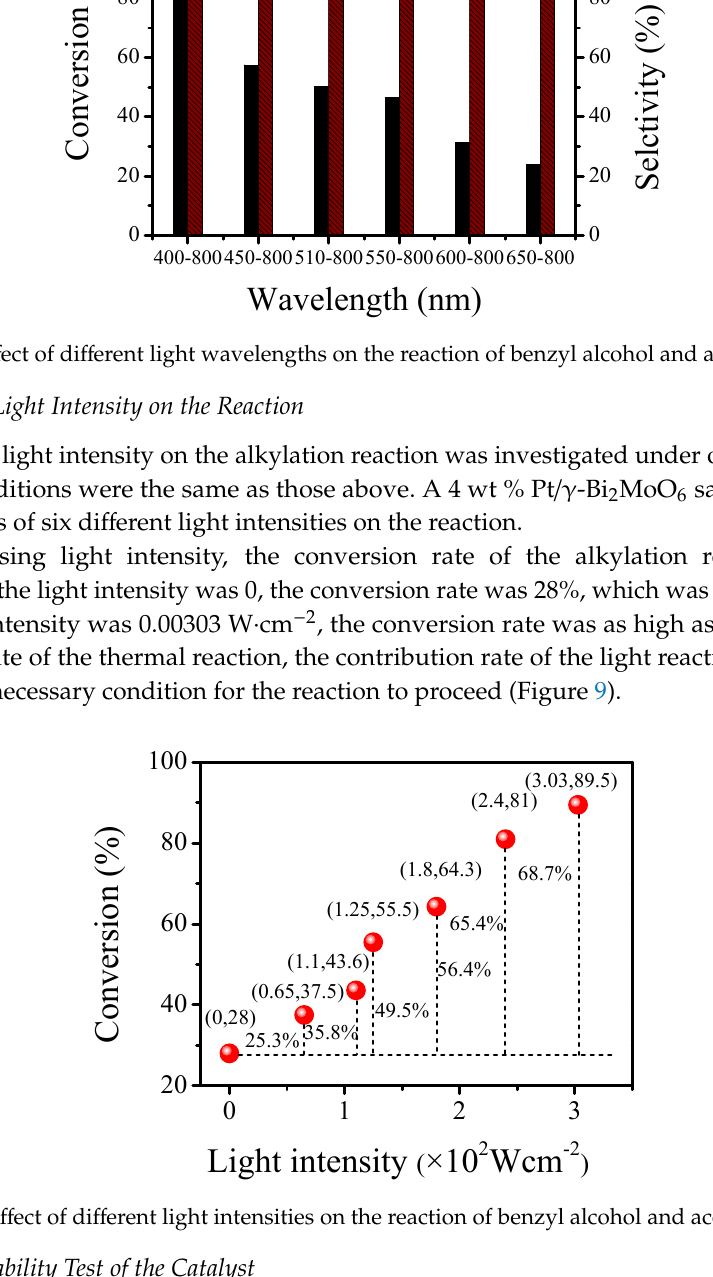
Figure 9. Effect of different light intensities on the reaction of benzyl alcohol and acetophenone.